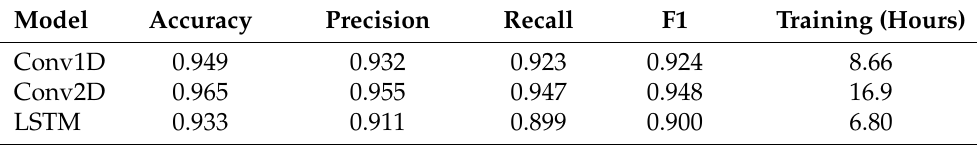
Table 3. Performance evaluation and training time required by all three models with 1.7 s split time.